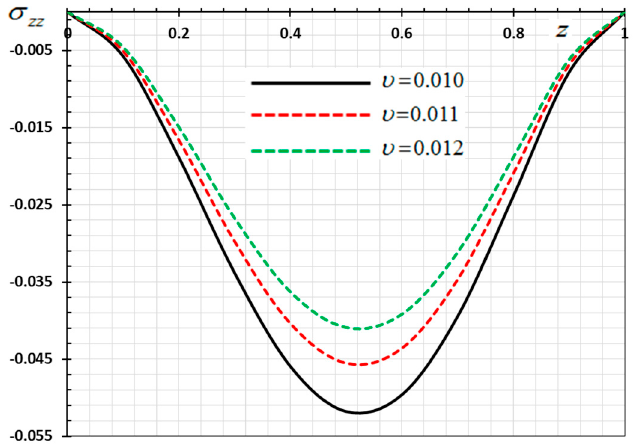
Figure 16. Variation of electric potential 𝜑 versus 𝑧 for different velocity of the heat source 𝜐 .